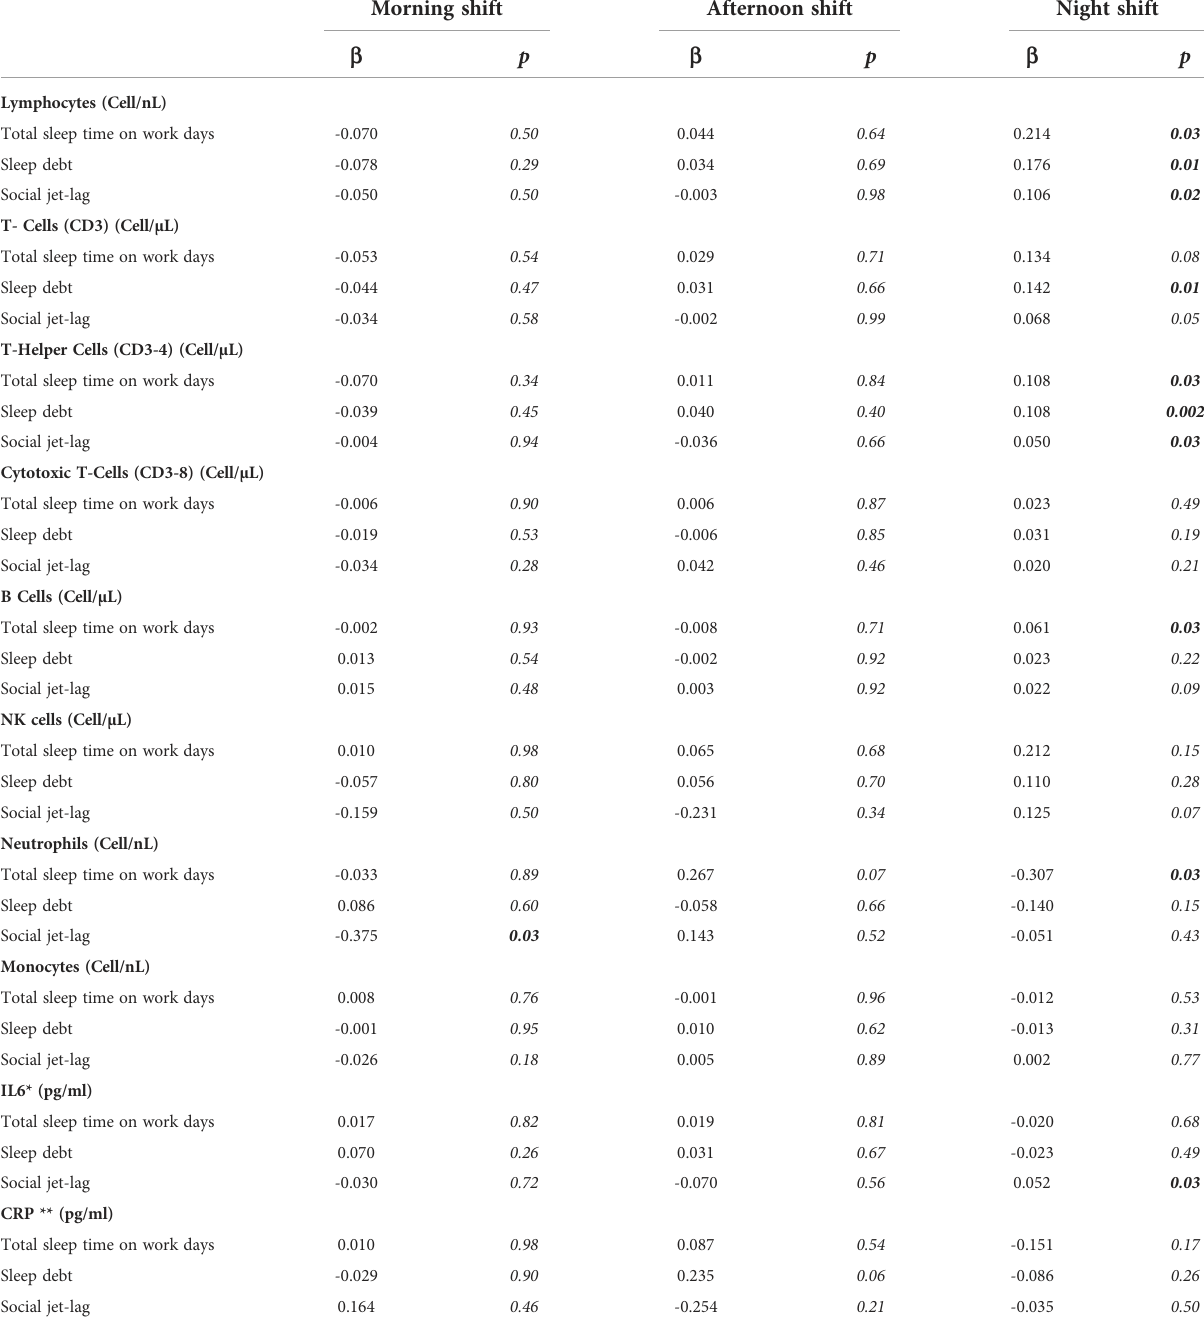
TABLE 4 Multivariate models showing the effects on immune biomarkers of total sleep time during work days (TST24w), sleep debt and social jet-lag among morning, afternoon and night shifters. Morning shift Afternoon shift Night shift b p b b